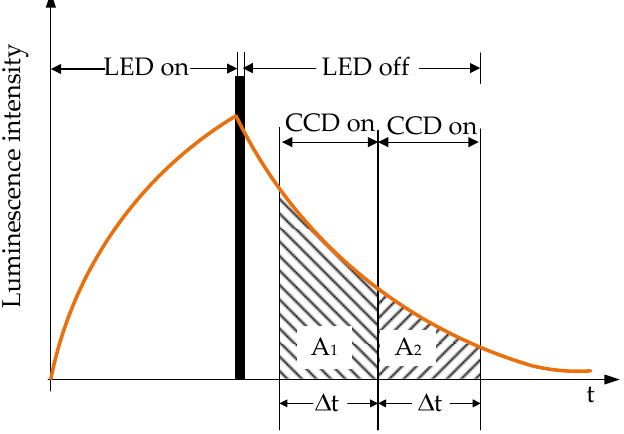
Figure 11. Method used for the rapid determination of the lifetime.